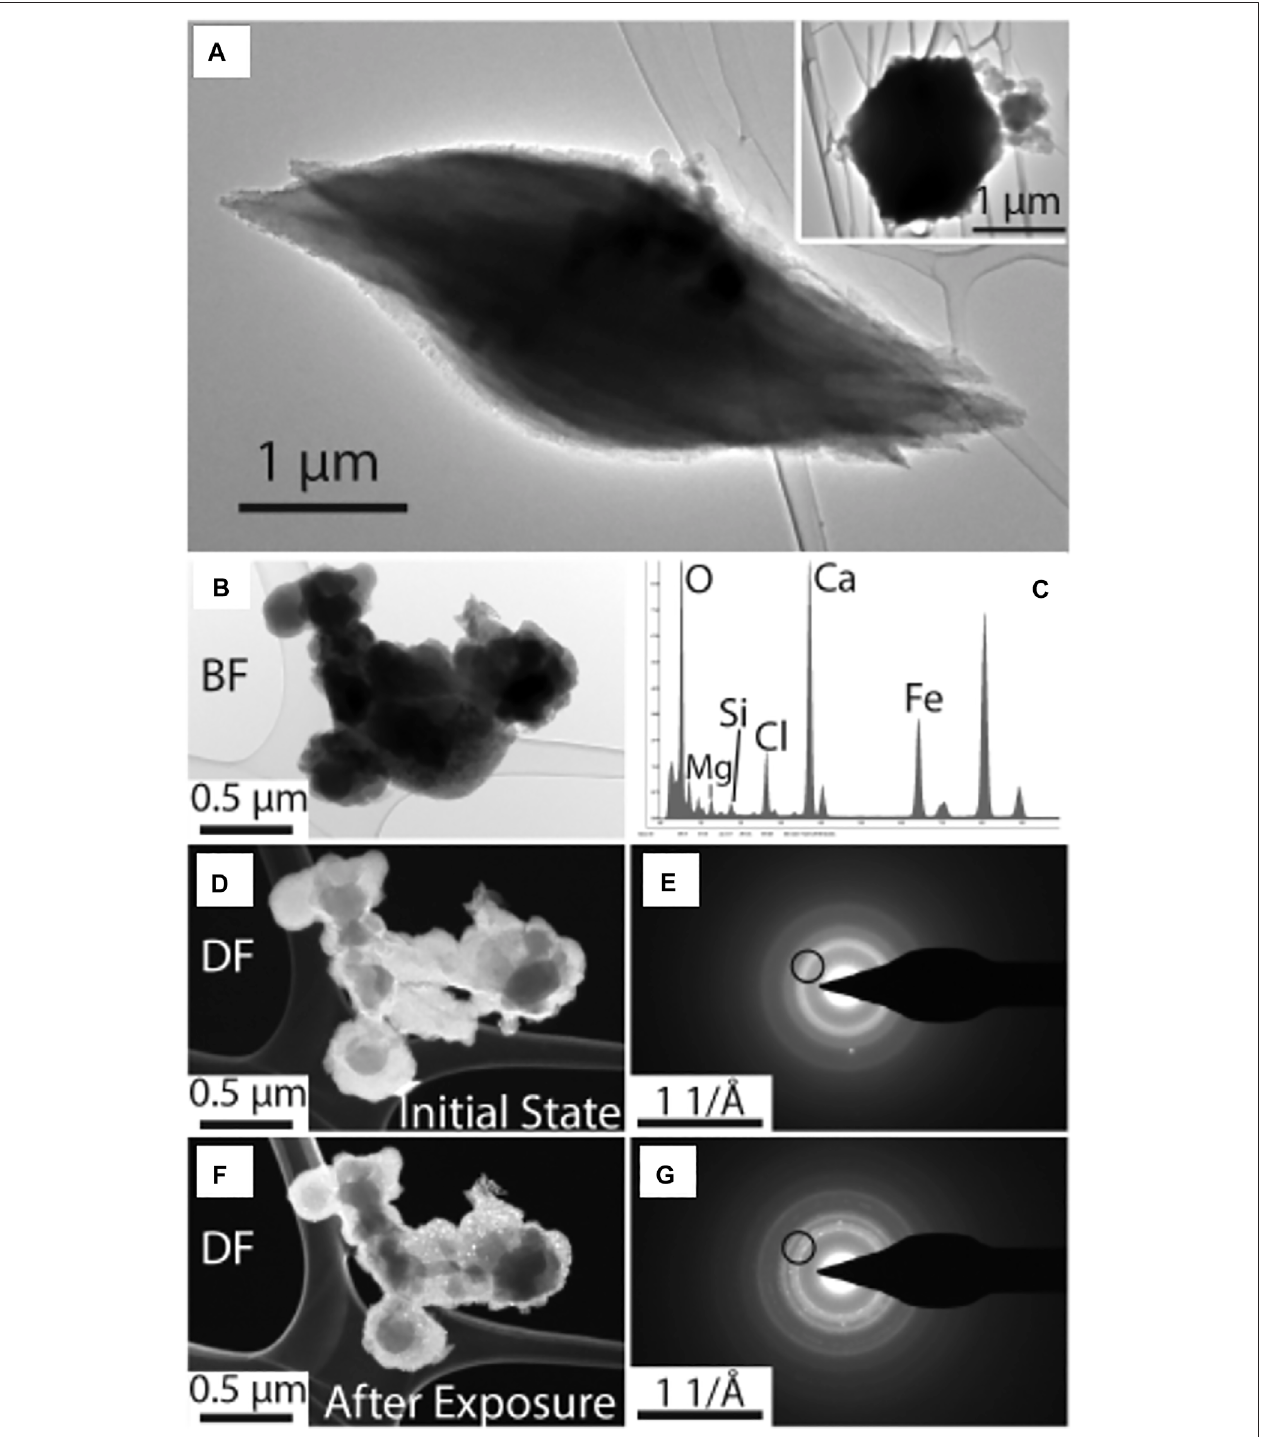
FIGURE 11 | TEM Results for ES128. (A) Aragonite in the “ seed ” habit. The cross-section pro fi le in included in the inset image. (B) Bright- fi eld image of AFSN in ES128. (C) EDX analysis of entire AFNS collection. (D) Dark fi eld image of the initial state of AFNS and it ’ s SAED pattern. The beam used to obtain the DF image is indicatedbytheblackcirclein (E , G) .Afterseveralminutesofexposuretotheelectronbeam,partsofthecollectionaltertocrystallinenanoparticles.Thenanoparticlesare bright in (F) and yield spots in SAED in (G) . AFNS that are truly spherical do not damage while more irregularly shaped amorphous material crystallize into a spinel- like structure ( see Supplementary Figure S36